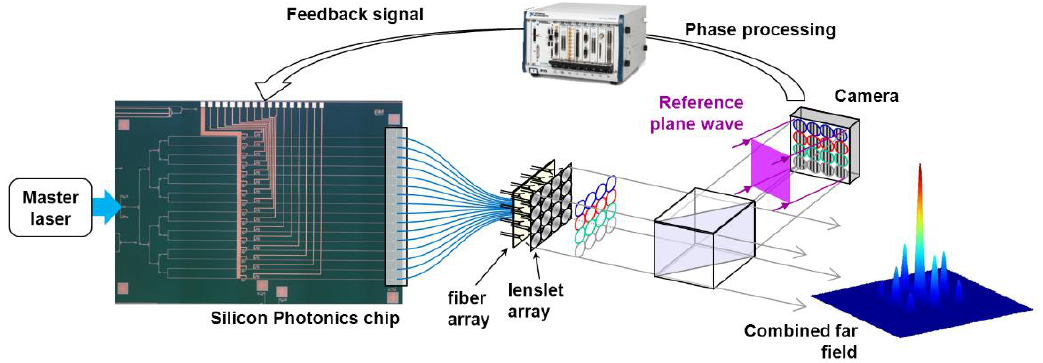
Figure 8. Schematic of the CBC experimental setup with active phase locking.